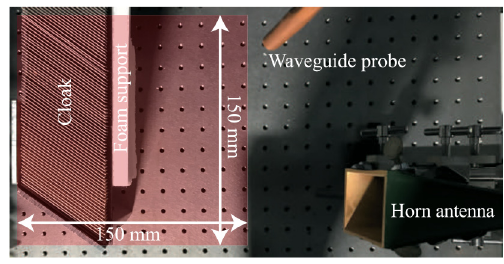
Fig. 3. Top view of the measurement system. The measured area is colored in red.